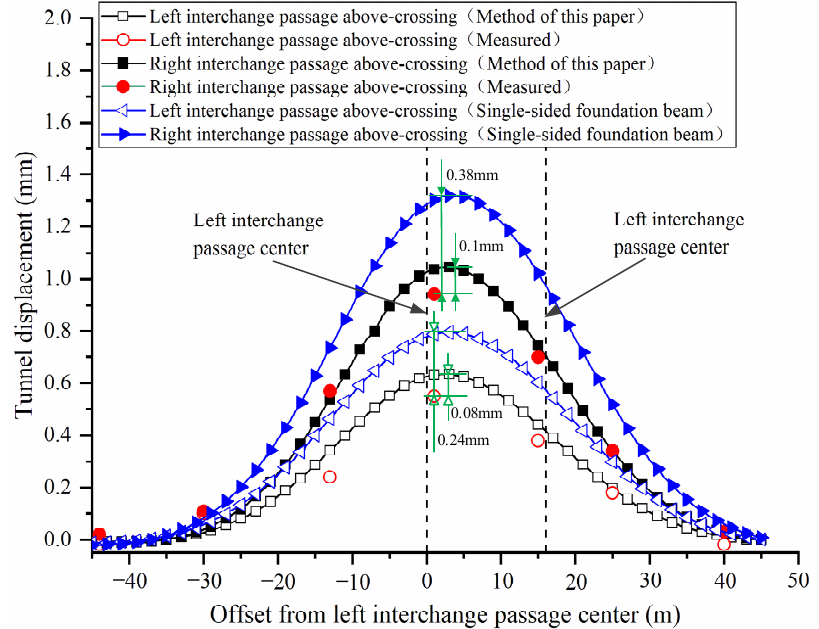
Figure 8. Comparison between the measured and calculated tunnel displacements due to the interchange passages above- crossing north shield tunnel of Line 10. interchange passages above-crossing north shield tunnel of Line